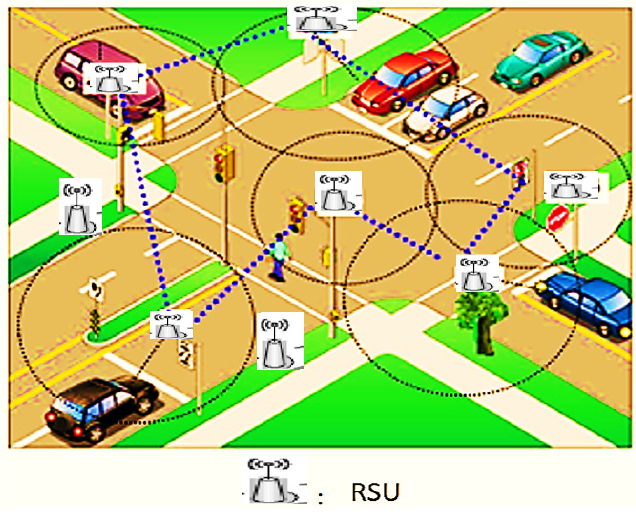
Figure 1. Architecture of VANET.